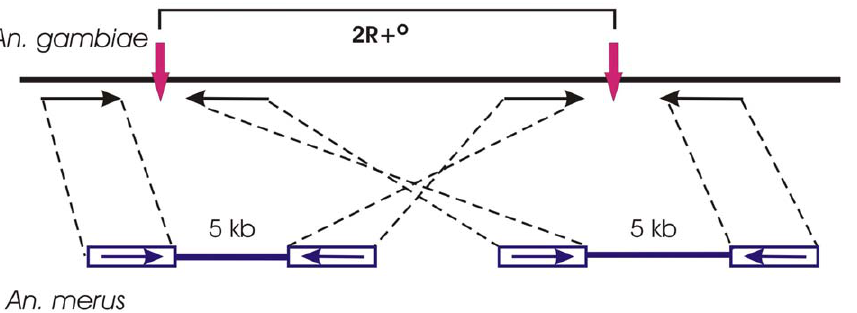
Figure 3. A scheme showing the utility of mate-paired sequencing for identifying inversion breakpoints. The BLASTN search of An. merus mate-paired sequencing reads (horizontal arrows) detects the 2R + o inversion breakpoints (vertical arrows) in the An. gambiae AgamP3 genome assembly.